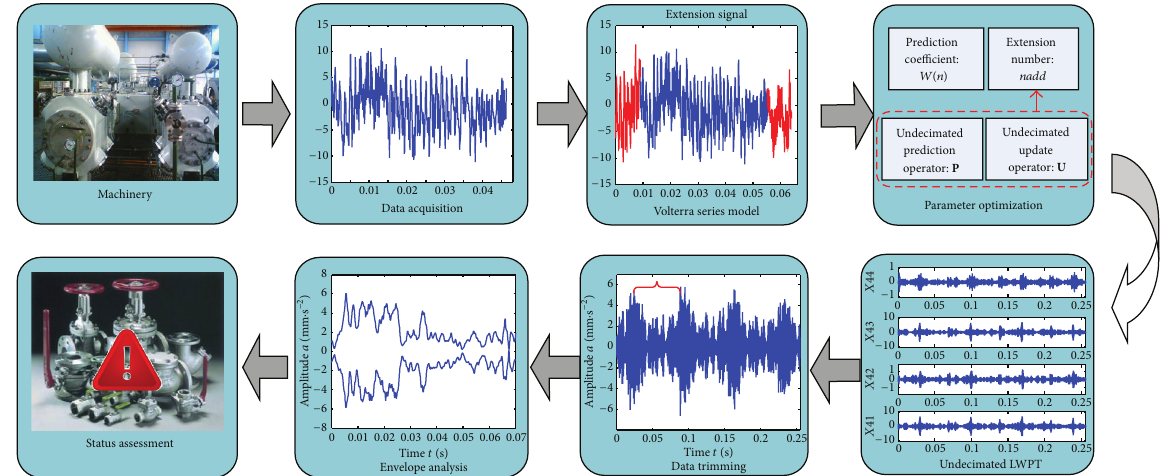
Figure 1: Flowchart of the proposed approach for machinery incipient defect